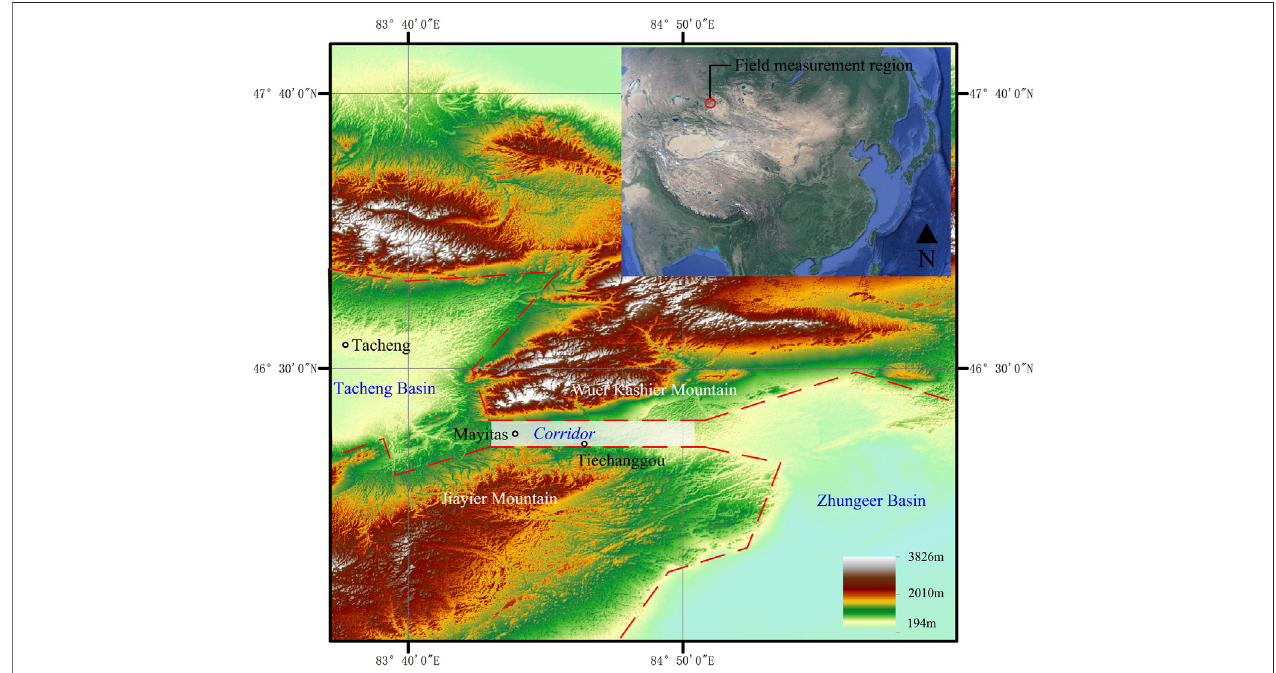
FIGURE 1 | Terrain map of the Mayitas area (Sub- fi gure data: SIO, NOAA, U. S. Navy, NGA, GEBCO). The narrow corridor between the mountains is specially markedin Figure 1 .Whenair fl oworiginatingfrom thebasinmoves throughthenarrowcorridor, movement isblocked bymountainstothenorthand south, buttheland is open to the east and west, which provides natural conditions for forming the narrow-tube effect. There are two main factors to form snowdrift: win and snow. The particular terrain of the measured area makes this area have strong wind, and both wind direction and speed are relatively stable.